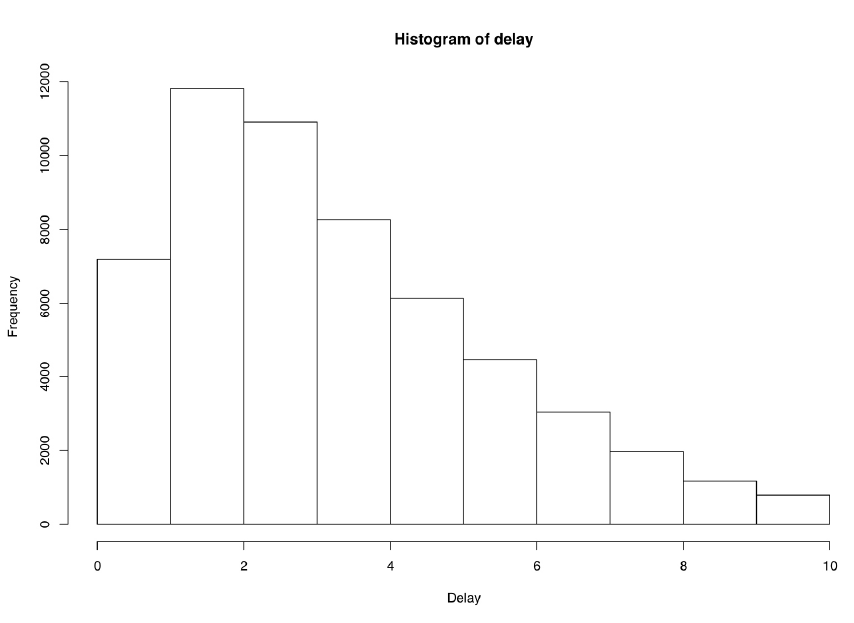
Figure 3 – Histogram of the